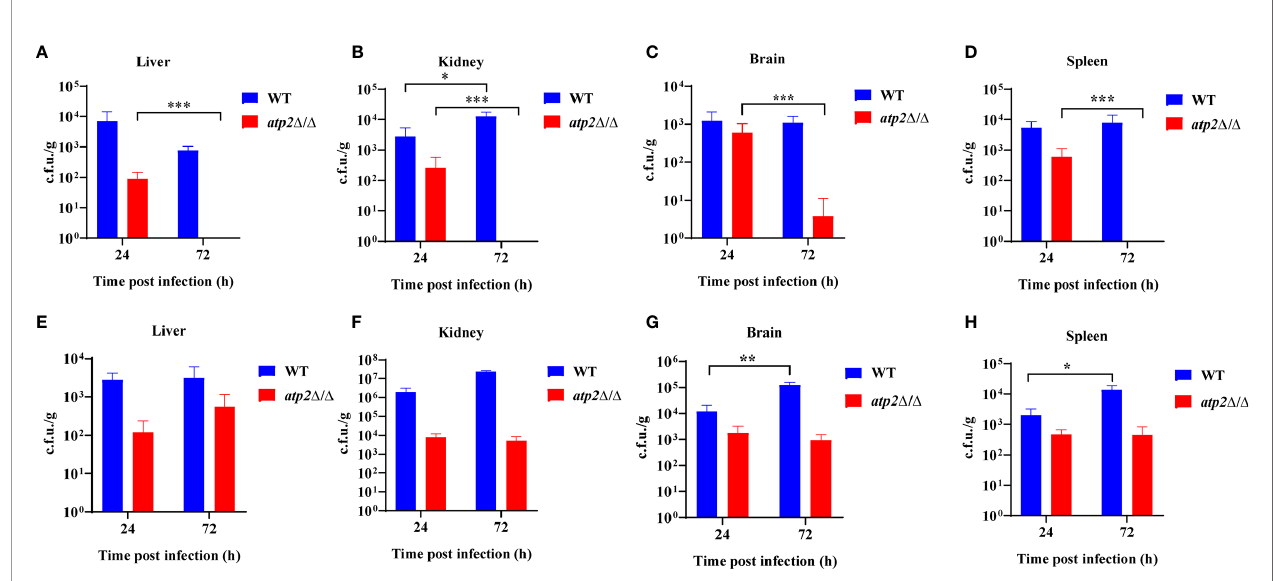
FIGURE 2 | ATP2 is required for C. albicans to resist macrophage clearance in vivo . (A – D) Fungal burden in the liver (A) , kidney (B) , spleen (C) , and brain (D) of mice injected with PBS liposomes 24 h before and 24 h after intravenous infection with C. albicans (2×10 5 CFU per mouse). (E – H) Fungal burden in the liver (E) , kidney (F) , spleen (G) , and brain (H) of mice injected with clodronate liposomes 24 h before and 24 h after intravenous infection with C. albicans (2×10 5 CFU per mouse). Each group includes 3 mice. In (A – H) , data are shown as mean ± s.d. * P< 0.05, ** P <0.01, *** P <0.001; by Student ’ s t